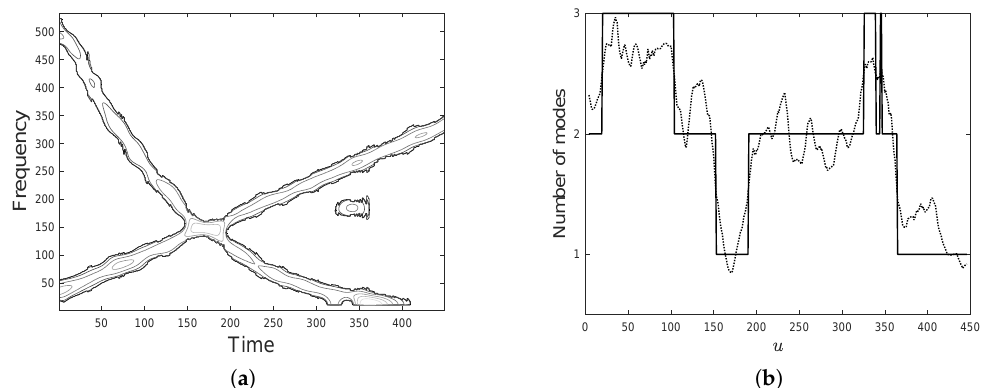
Figure 17. ( a ) Thresholded spectrogram in Figure 16b by using the optimal values in Figure 16c. ( b ) Estimated number of modes by applying the Rényi entropy-based method to ( a ). Local Rényi entropy (dotted line) and its rounded value (solid line).